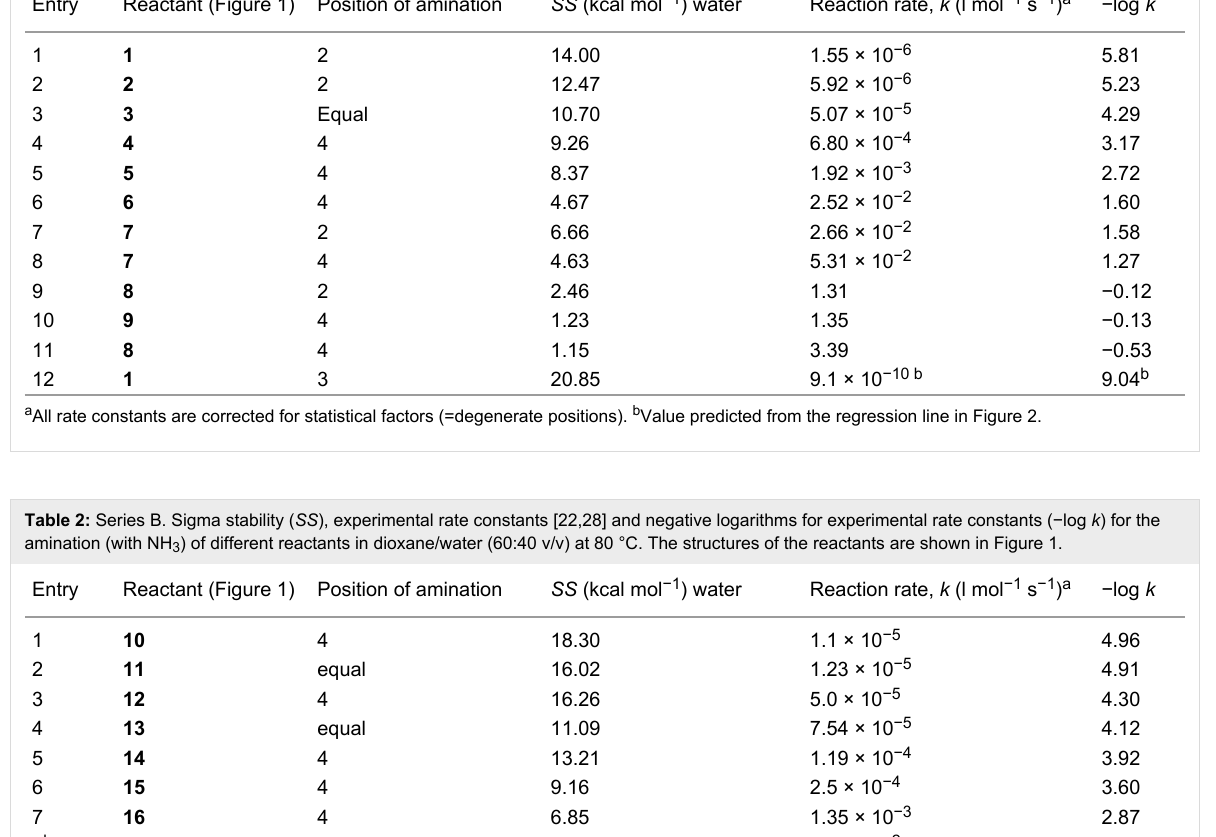
values in methanol and experimental –log k values are shown in Figure 4. The overall picture for this data set is quite analogous to the previous two and the SS values for the structures where